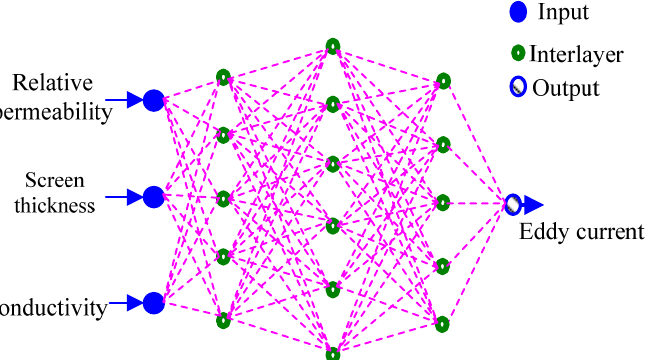
Figure 12. BPNN model with different hidden layers of a 5–6–5 structure.